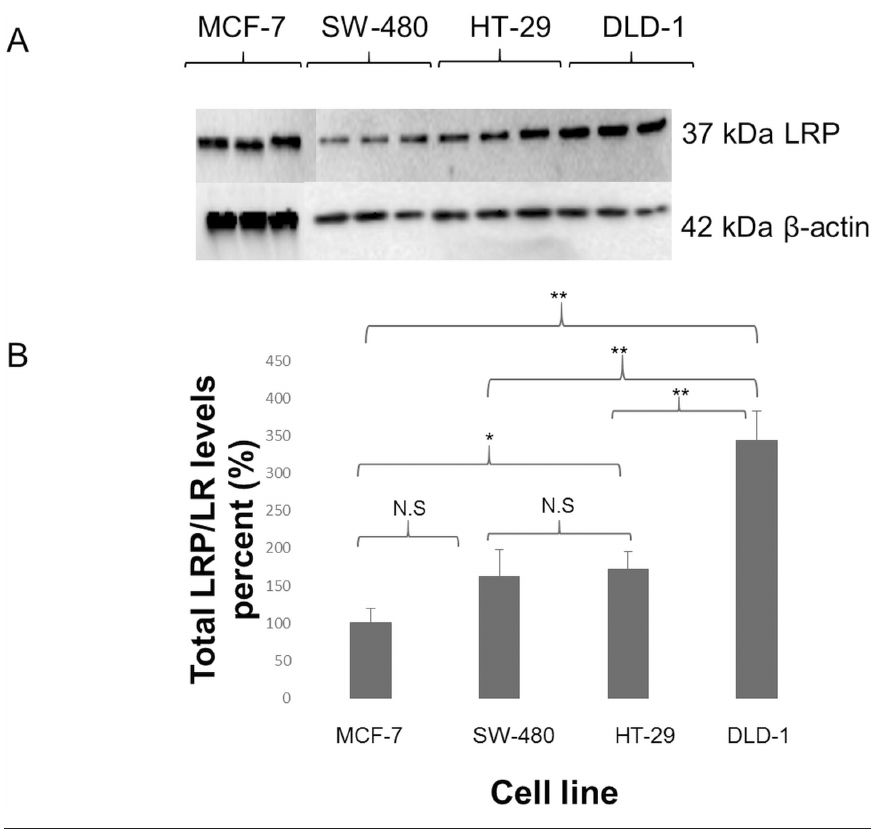
Figure 4. (A) Detection of total 37 kDa LRP levels in protein lysates of MCF-7, SW-480, HT-29 and DLD-1 cells. IgG1-iS18 was used as the primary antibody, with HRP-coupled secondary antibody; 42kDa β -actin was used as a loading control. (B) Densitometric analysis of total LRP/LR levels on SW-480, HT-29 and DLD-1 cell lines revealed that, compared to MCF-7, DLD-1 contained the most total LRP/LR, displaying a 3.5-fold increase. A significant two-fold increase in total LRP/LR levels between early- and late-stage colorectal cancer was also found. These data represent experiments performed in triplicate using different cell